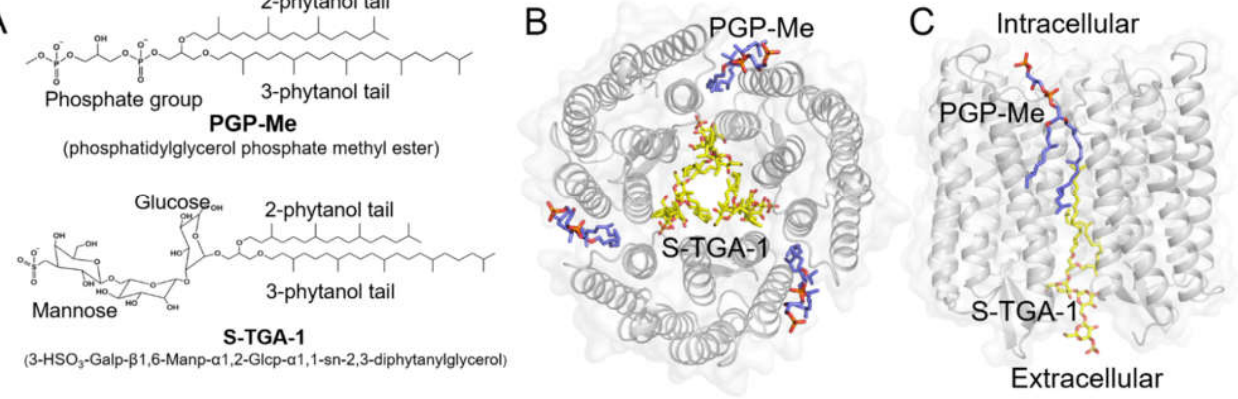
Figure 1. Schematic diagram of the structures of S-TGA-1, PGP-Me, and the bacteriorhodopsin (bR) trimer. ( A ) Molecular structures of S-TGA-1 and PGP-Me; ( B , C ) top and front view for the locations of S-TGA-1 (yellow sticks) and PGP-Me (dark blue sticks) within the bR trimer (grey cartoon).